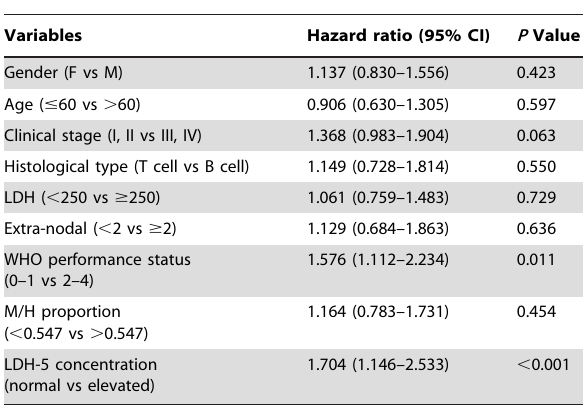
Table 3. Multivariate Cox proportional hazard